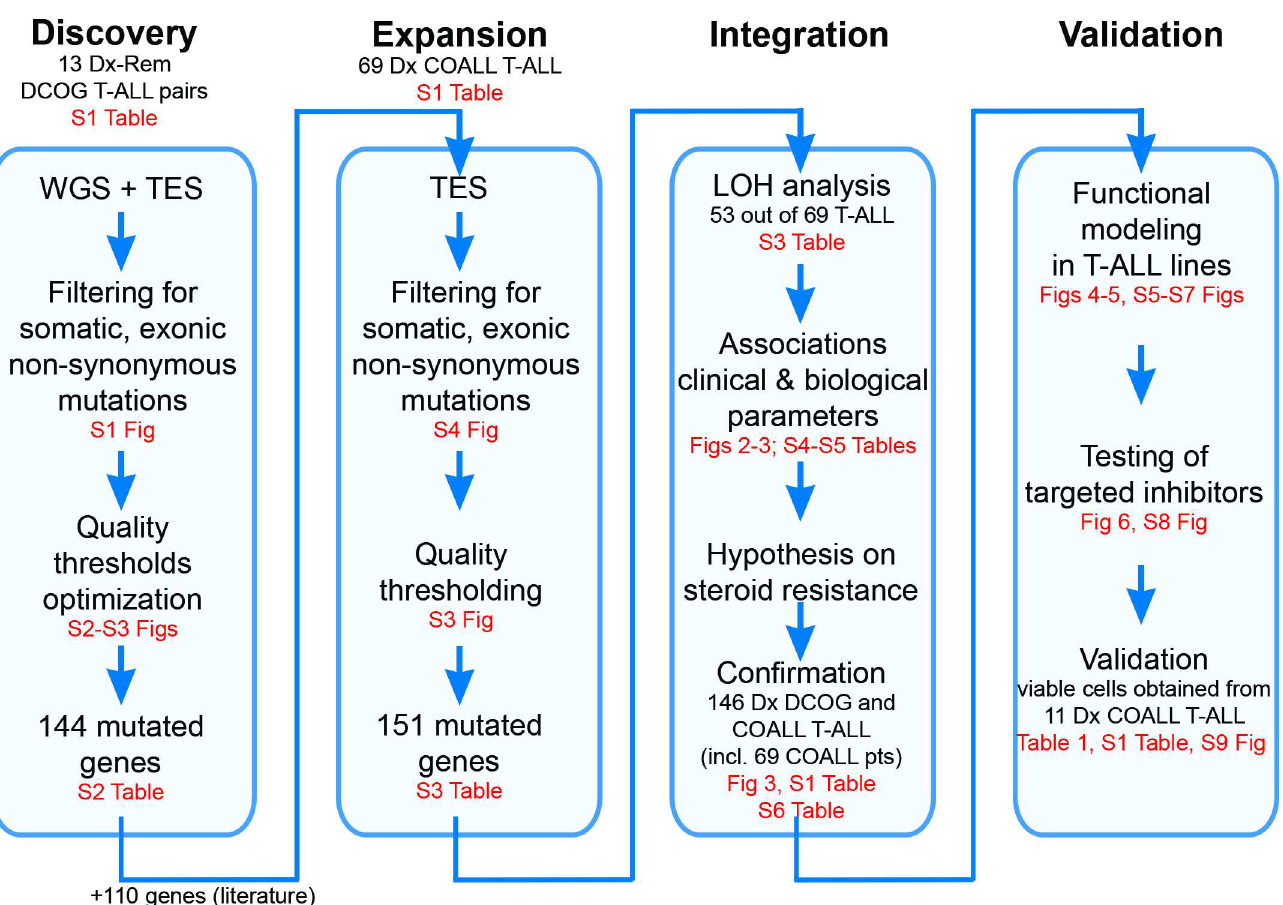
Fig 1. Study overview. Discovery phase: Whole genomesequencing (WGS) followedby targeted exome sequencing (TES) and prioritizationof high- confidencemutations in 13 paireddiagnostic (Dx)–remission (Rem) T cell acute lymphoblastic leukemia(T-ALL) patient samples. Expansion phase: TES for 254 geneson diagnostic materialsof 69 T-ALL patients. Integrationphase: Integrationof high-confidence TES mutation and array comparative genomic hybridization loss of heterozygosity (LOH) datasets and associationswith clinicaland biologicaldata. Confirmation of findings was done using an extendedcohort of 146 diagnostic T-ALL patient samples, includingthe 69 patients (pts) in the expansionphaseand 77 additional patients. Validationphase: Functional modelingin T-ALL cell lines, determination of efficacy of targeted inhibitorsto revert phenotype, and testing in primary T-ALL patient samples. COALL, Co-operative Study Group for Childhood Acute Lymphoblastic Leukemia;DCOG, Dutch Childhood Oncology Group.